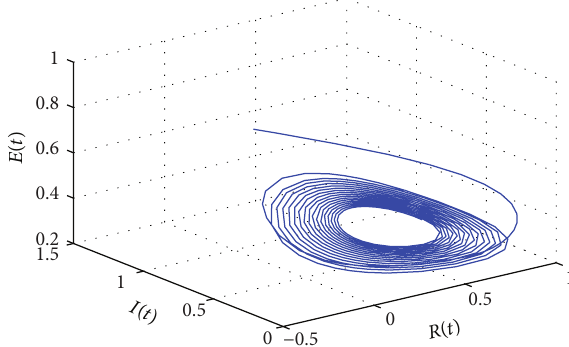
Figure 1: The phase plot of the states 𝑆 , 𝐸 , and 𝐼 for 𝜏 = 8.0025 < 8.9829 = 𝜏 0 .